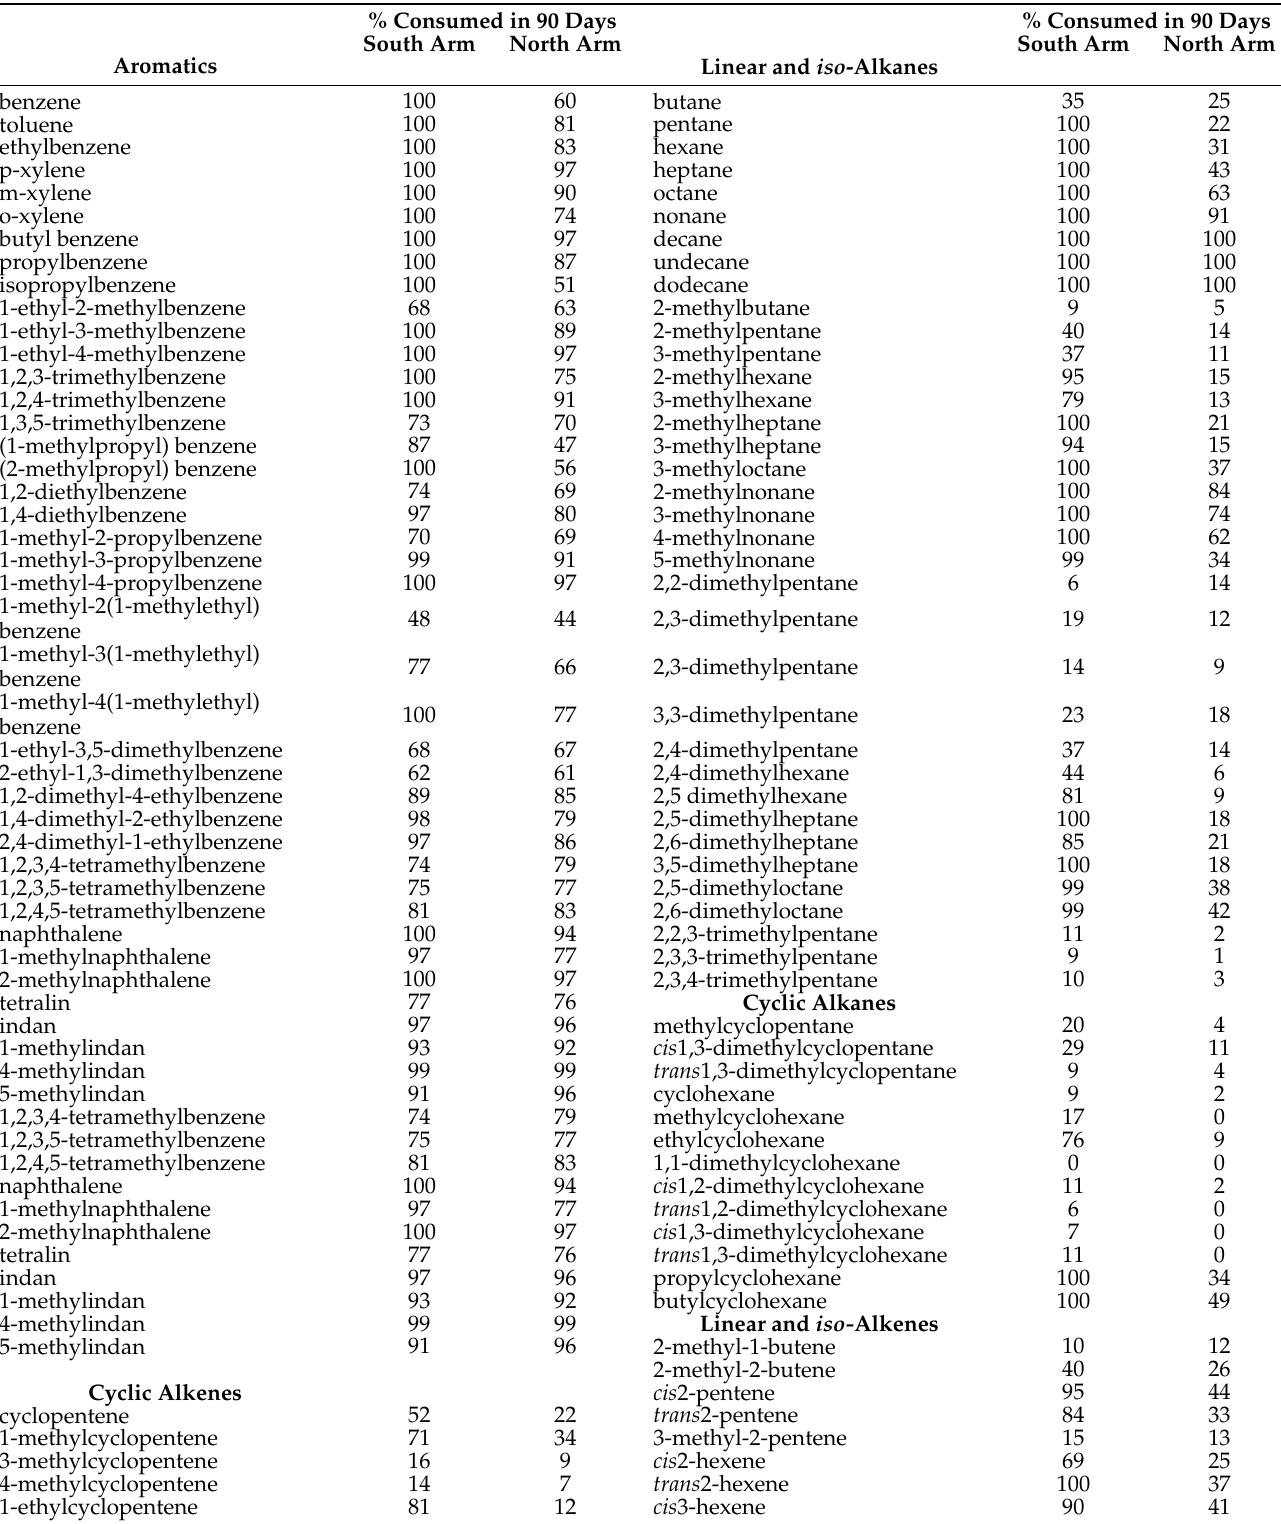
Table 1. The biodegradation of gasoline hydrocarbons in 90